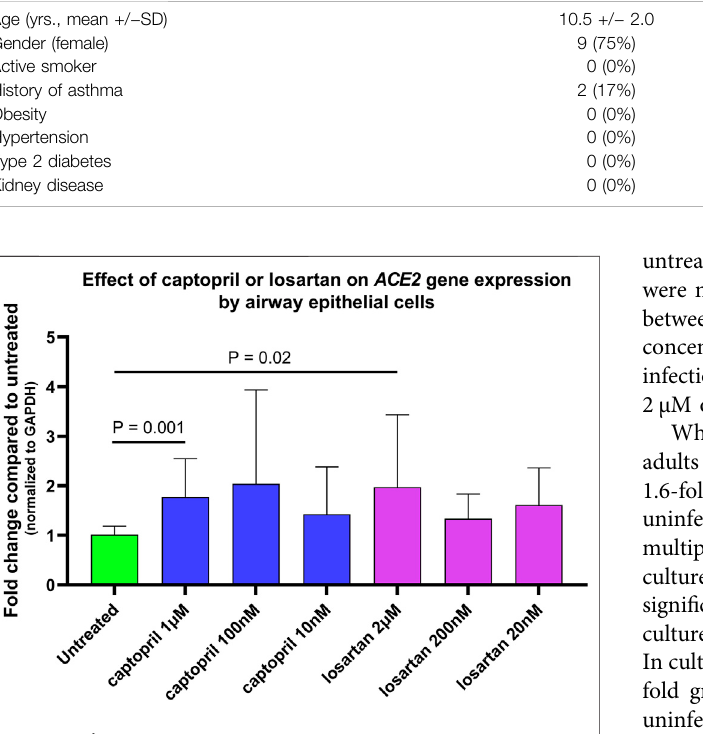
FIGURE 1 | Relative ACE2 gene expression (normalized to GAPDH expression) by untreated and captopril or losartan treated organotypic airway epithelial cell cultures. Cultures were treated with 1 µM, 100 nM, or 10 nM of captopril, and 2 µM, 200 nM, or 20 nM of losartan added to basolateral culture medium with each medium change for 7 days prior to RNA isolation. Each experimental condition was tested in triplicate wells of primary airway epitheliallinesfromthreedifferentchildren.Treatmentofcultureswithcaptopril or losartan led to signi fi cant increases in ACE2 expression (Friedman ANOVA p (cid:1) 0.0002) at concentrations of 1 µM of captopril (Dunn ’ s multiple comparison test for untreated vs. captopril treated cultures p (cid:1) 0.001) and 2 µM of losartan (Dunn ’ s multiple comparison test for untreated vs. losartan treated cultures p (cid:1) 0.02), however, there were not statistically signi fi cant differences in ACE2 expression between the different concentrations of captopril or different concentrations of losartan